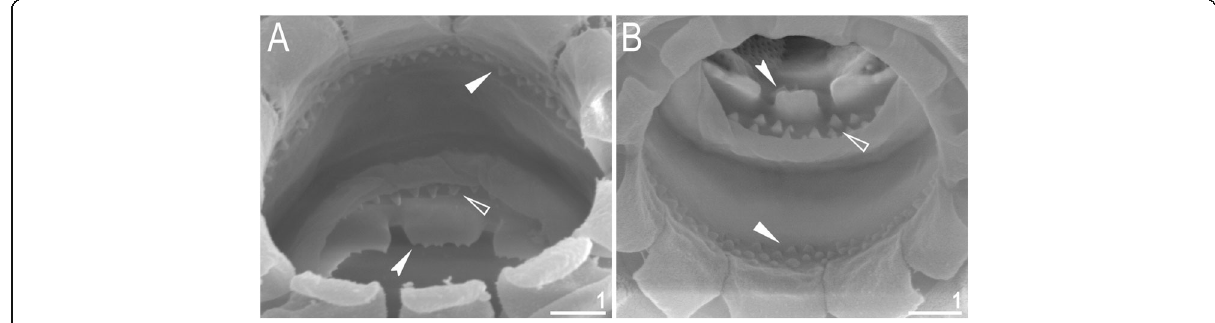
Fig. 35 Macrobiotus margoae sp. nov. from USA (US.057) – the oral cavity armature seen with SEM: a – b – the oral cavity armature of a single specimen seen in SEM from different angles showing dorsal and ventral portion, respectively. Filled flat arrowheads indicate the first band of teeth, empty flat arrowheads indicate the second band of teeth, and filled indented arrowheads indicate the third band of teeth. Scale